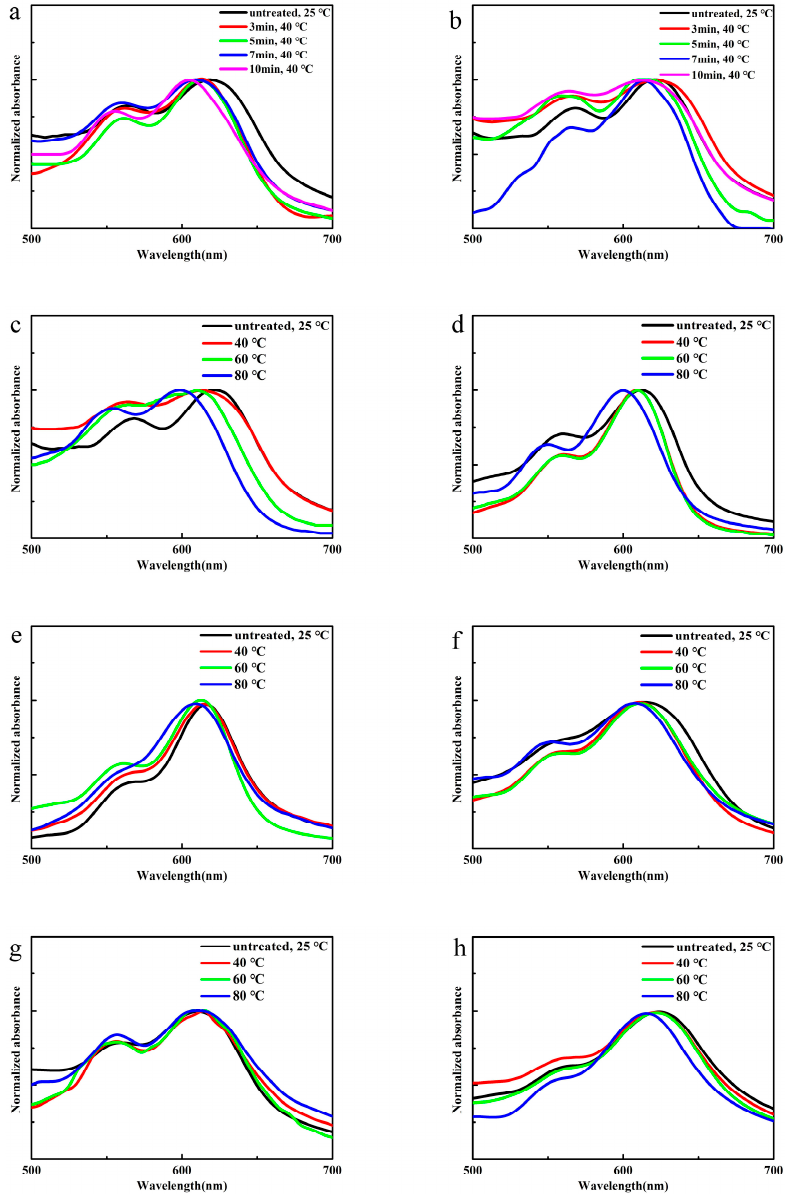
Figure 14. Normalized UV–vis absorption spectra of PBI-1 aggregates with ammonia treatment. ( a ) r = 30:1 p-toluenesulfonic acid, 40 °C, ( b ) r = 50:1 p-toluenesulfonic acid, 40 °C, ( c ) r = 50:1 p-toluenesulfonic acid, 10 min, ( d ) r = 50:1 oxalic acid, 10 min, ( e ) r = 100:1 malonic acid, 10 min, ( f ) r = 200:1 citric acid, 10 min, ( g ) r = 500:1 formic acid, 10 min and ( h ) r = 500:1 glutaric acid, 10 min.